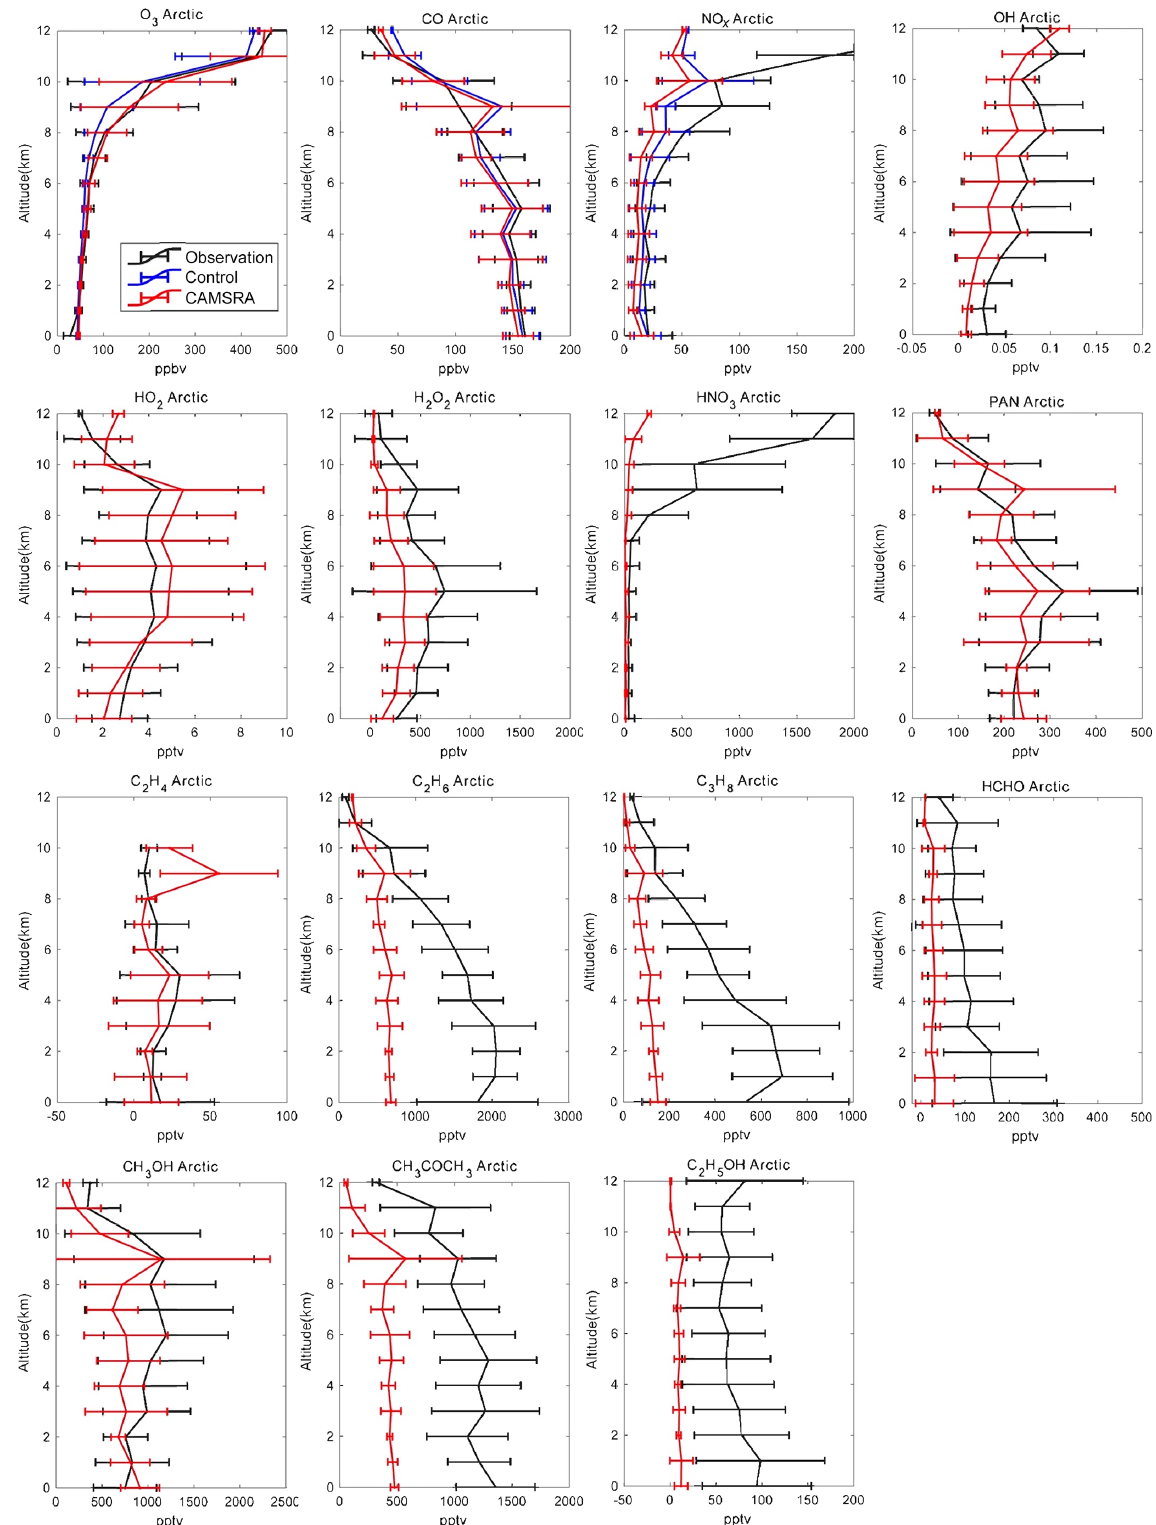
Figure 9. Averaged profiles of the trace constituents over the Arctic during the ARCTAS campaign from April to July 2008. The black lines are the observations, the red lines correspond to the CAMSRA reanalysis, and the blue lines are the control run (only shown for O 3 , CO and NO x ). The error bars represent the standard deviation of the data and